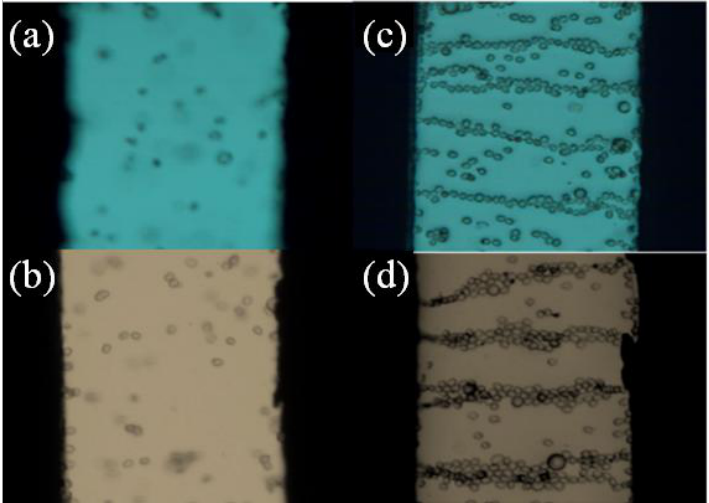
Figure 9. Optical microscopic images of the c-MWNT adsorbed SL particles using different surfactants dispersed in silicone oil (right) without an electric field [( a ) by using CTAB; ( b ) by using SDS] and with an electric field of 0.44 kV/mm [( c ) by using CTAB; ( d ) by using SDS) (reprinted with permission from [40], Copyright 2012